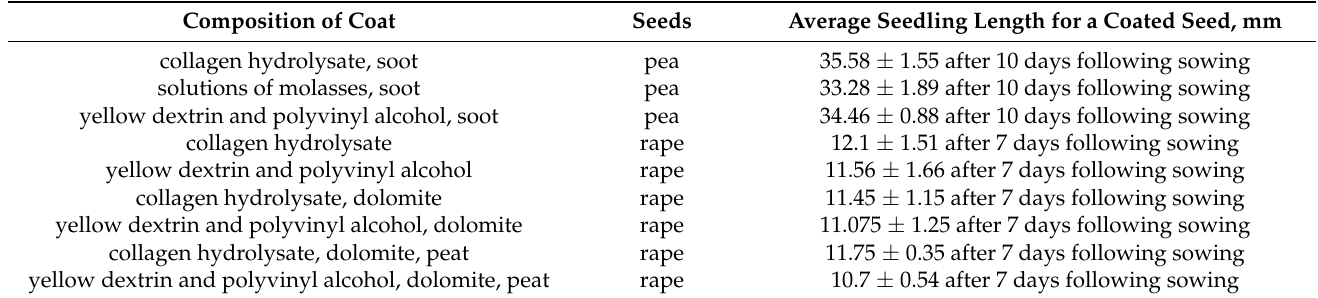
Table 5. Average seedling length for seeds coated with a different